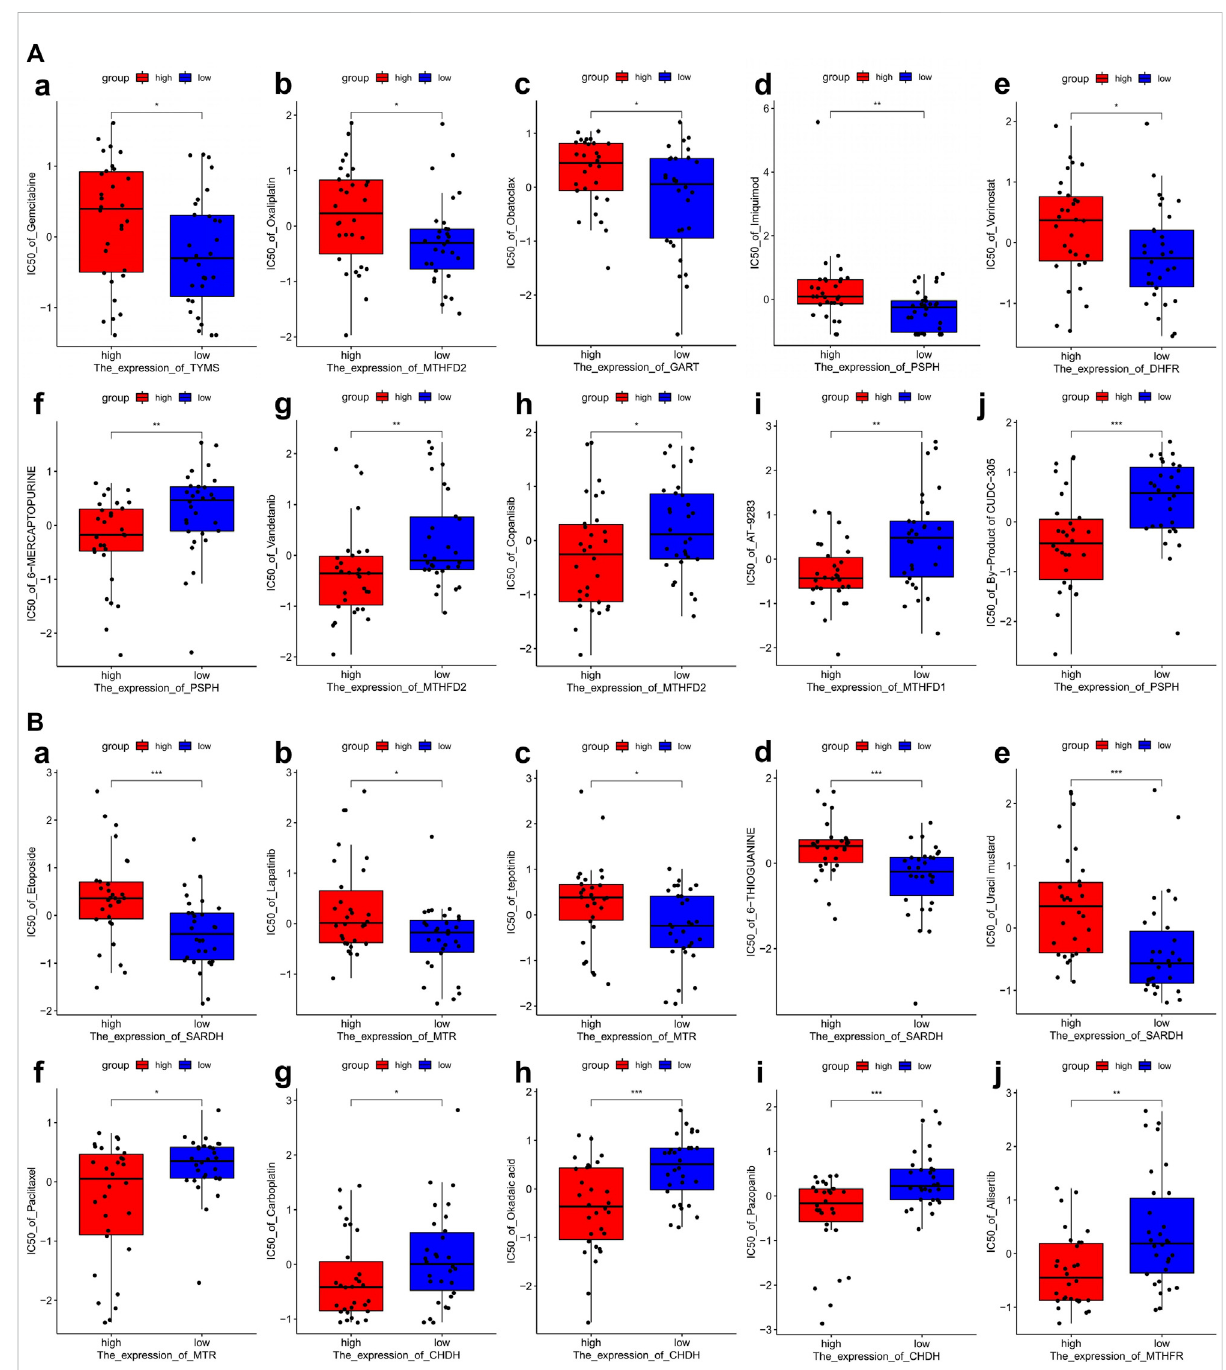
FIGURE 7 Drug sensitivity analysis of one-carbon metabolism associated genes. (A) Drug sensitivity analysis based on Cluster 1 expression pattern. (a – e) Five drugs with negatively related sensitivity, (f – j) Five drugs with positively related sensitivity; (B) Drug sensitivity analysis based on Cluster 2 expression pattern. (a – e) Five drugs with negatively related sensitivity, (f – j) Five drugs with positively related